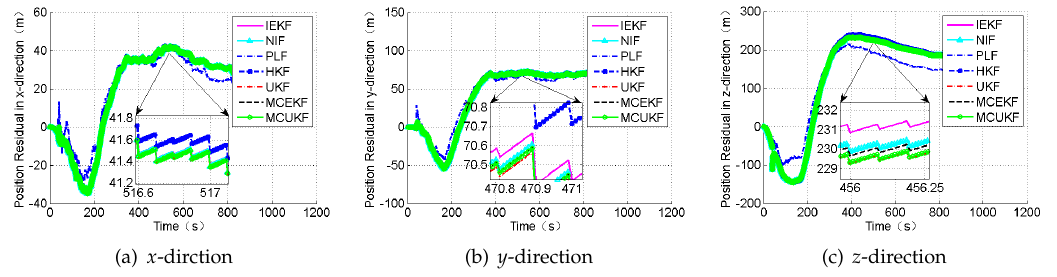
Figure 8. The position residual under the condition of Gaussian noise.